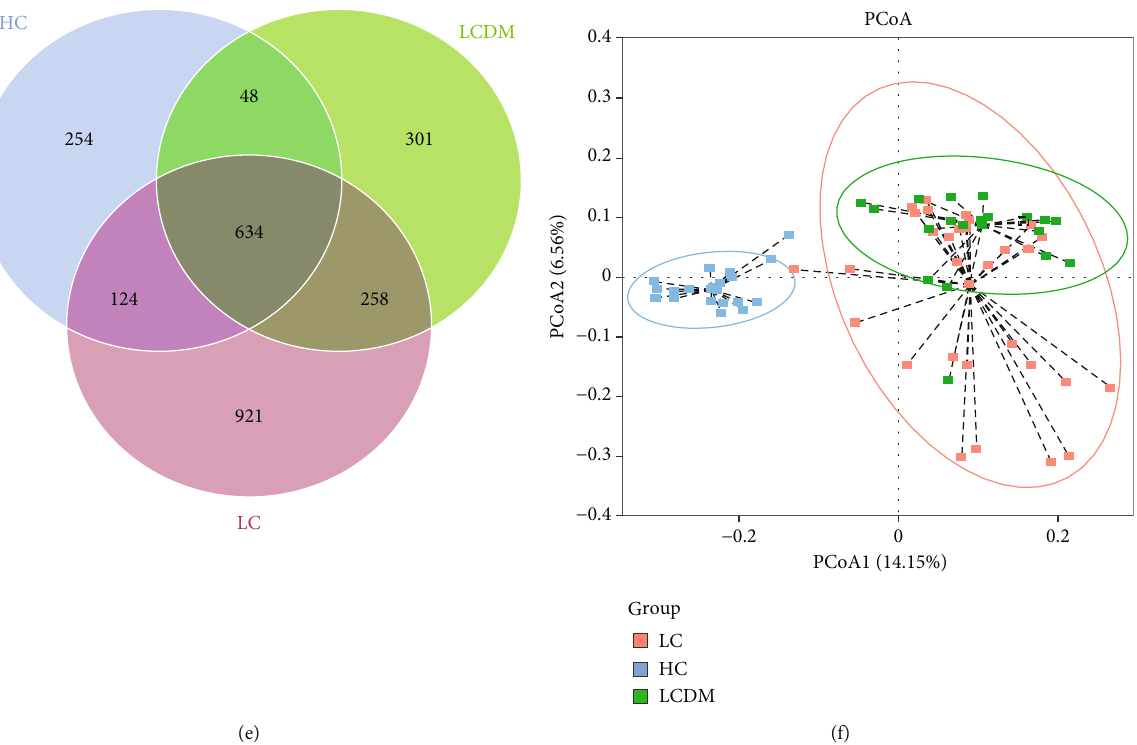
Figure 2: Comparison of intestinal microbiota diversity among HC, LC, and LCDM. (a) The rarefaction curve tends to be fl at, indicating that the sequencing depth was su ffi cient. (b) The rank abundance curve tends to be fl at, indicating even species distribution. (c) Chao1 index and (d) ACE index signi fi cantly decreased in LCDM. (e) The Venn diagram showed that 892 OTUs were shared between LC and LCDM, and 301 OTUs were unique to LCDM. (f) The β diversity of PCoA analysis based on binary Jaccard distance showed that the samples of intestinal microbiota in the HC group were clustered and were farther away from those in the LC and LCDM groups, while the spatial distance between samples in the LC and LCDM groups was less. HC: healthy controls; LC: HBV-related liver cirrhosis; LCDM: hepatitis B liver cirrhosis and diabetes